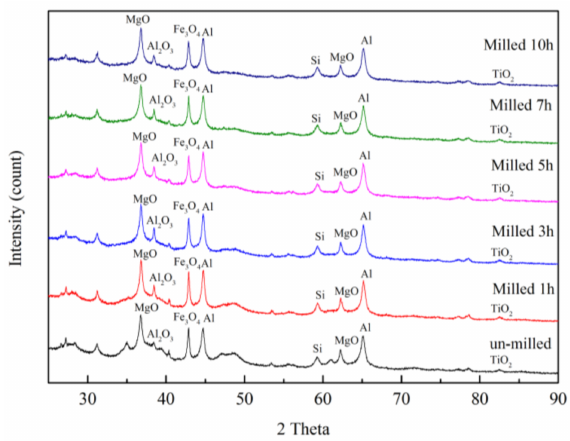
Figure 1. XRD pattern of mechanically activated back dross at different ball milling times. Table 2. Variation in the average crystallite size of mechanically activated black dross with ball milling